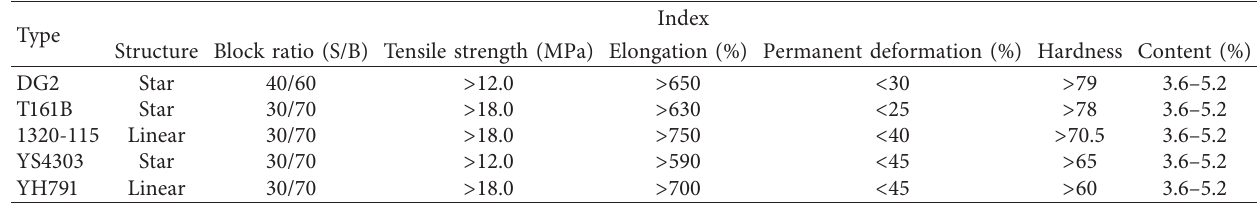
Table 2: Test parameters and their indexes of SBS modifier.